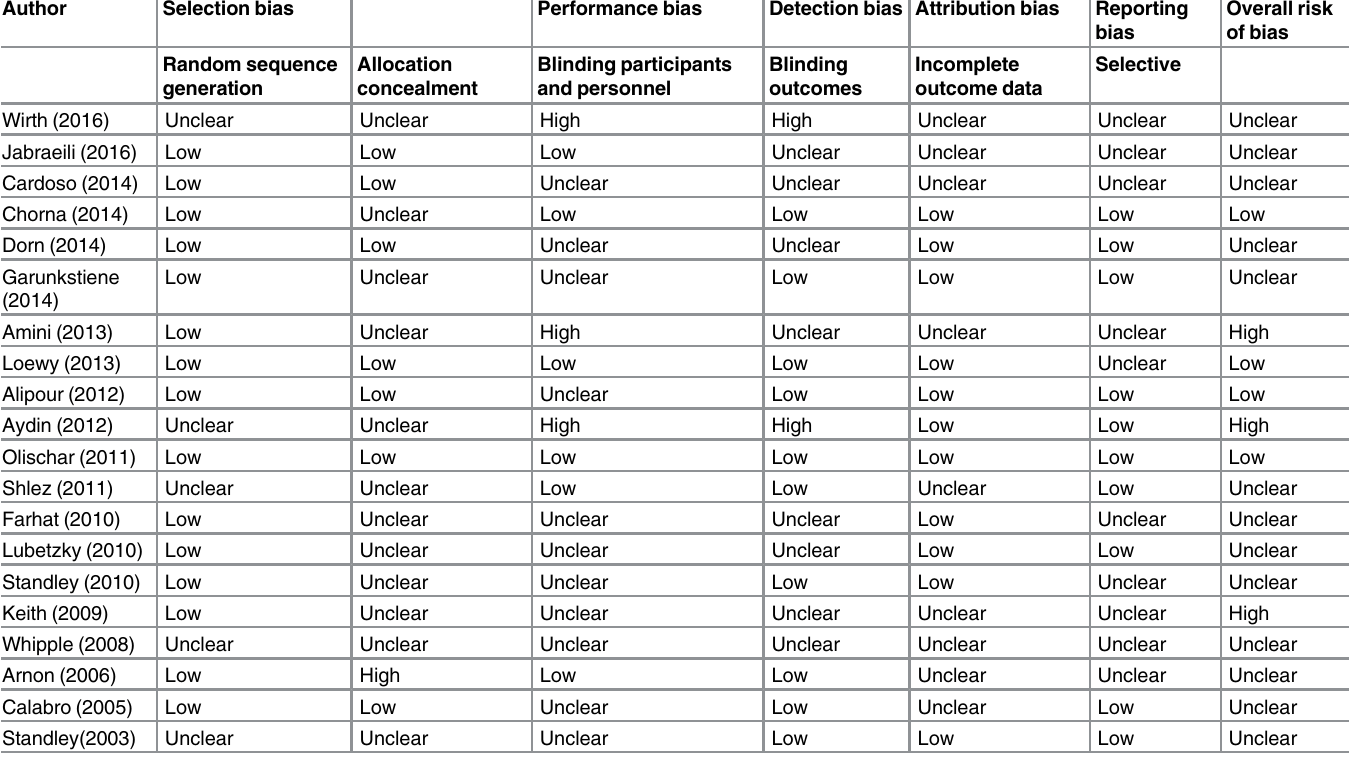
Table 1. Risk of bias. Cochrane Collaboration tool for assessing risk of